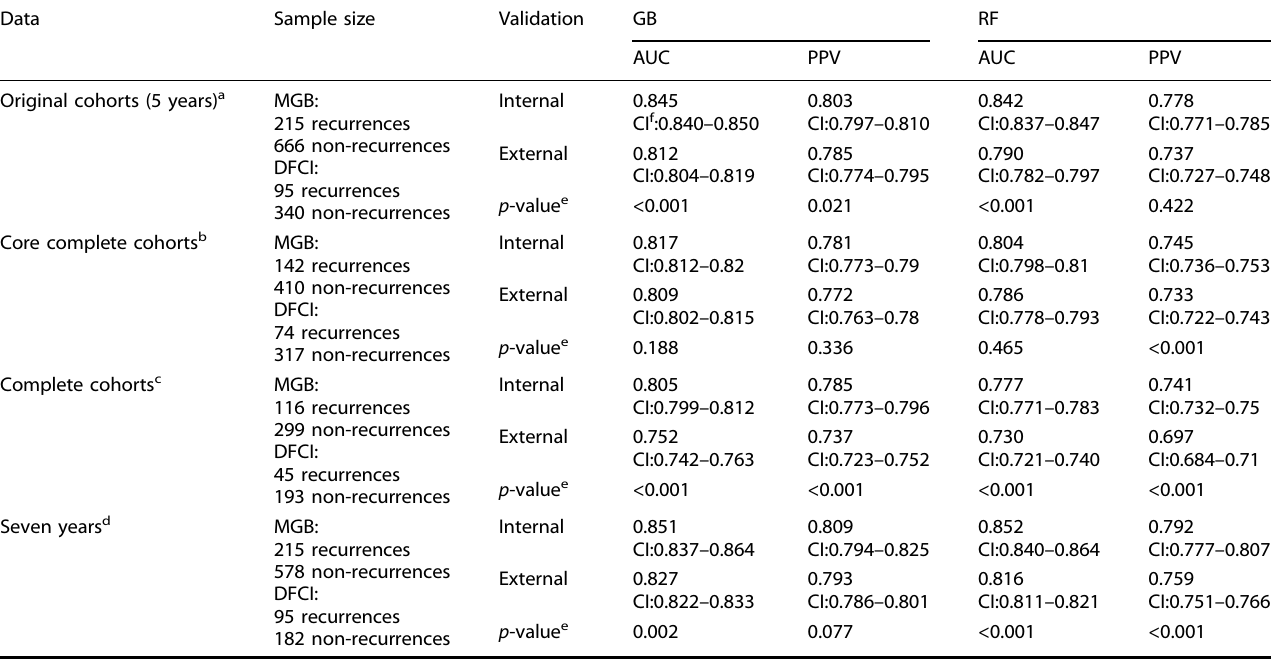
Table 2. Sensitivity analyses for recurrence classi fi cation by GB and RF